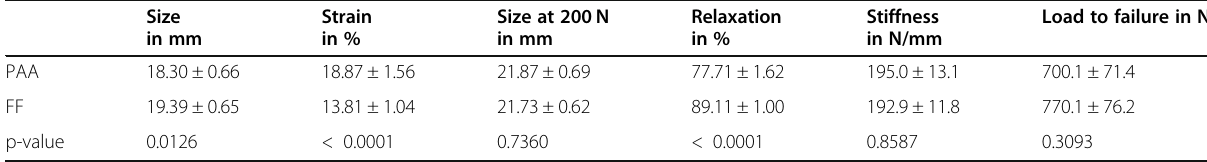
Table 1 Results of physiological and biomechanical comparison of peracetic acid sterilised (PAA) versus untreated fresh frozen (FF) menisci. Twenty two meniscus pairs were examined with regards to size, strain and size at 200 N, relaxation properties as well as stiffness and load to failure. Values are presented as MEAN ±